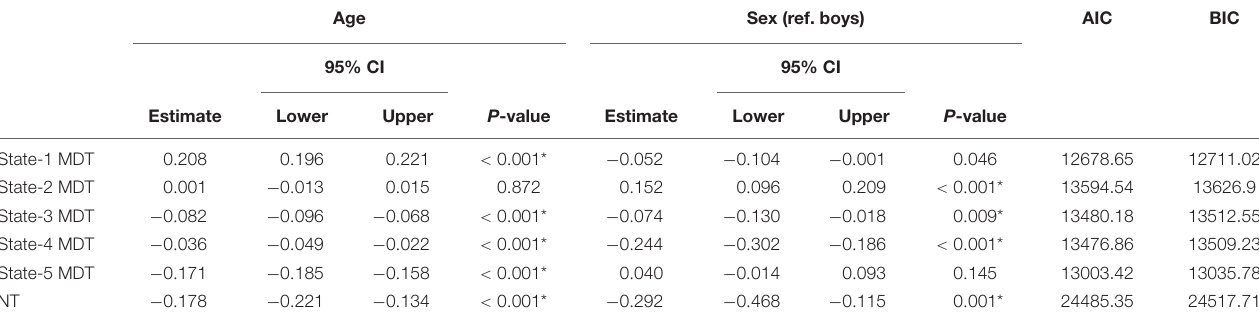
FIGURE 6 | Distributions of mean dwell time (MDT, number of time windows) in each state and number of transitions between states by visit and sex. Wilcoxon signed rank test was used to compare the values between age-10 and age-14 visits and Wilcoxon rank sum test was used to compare the values between boys and girls in each visit. * p -value < 0.05; n.s., non-significant. TABLE 2 | Age- and sex-associations with transformed mean dwell time (MDT, number of time windows) in each state and number of transitions (NT) between states. Age Sex (ref.